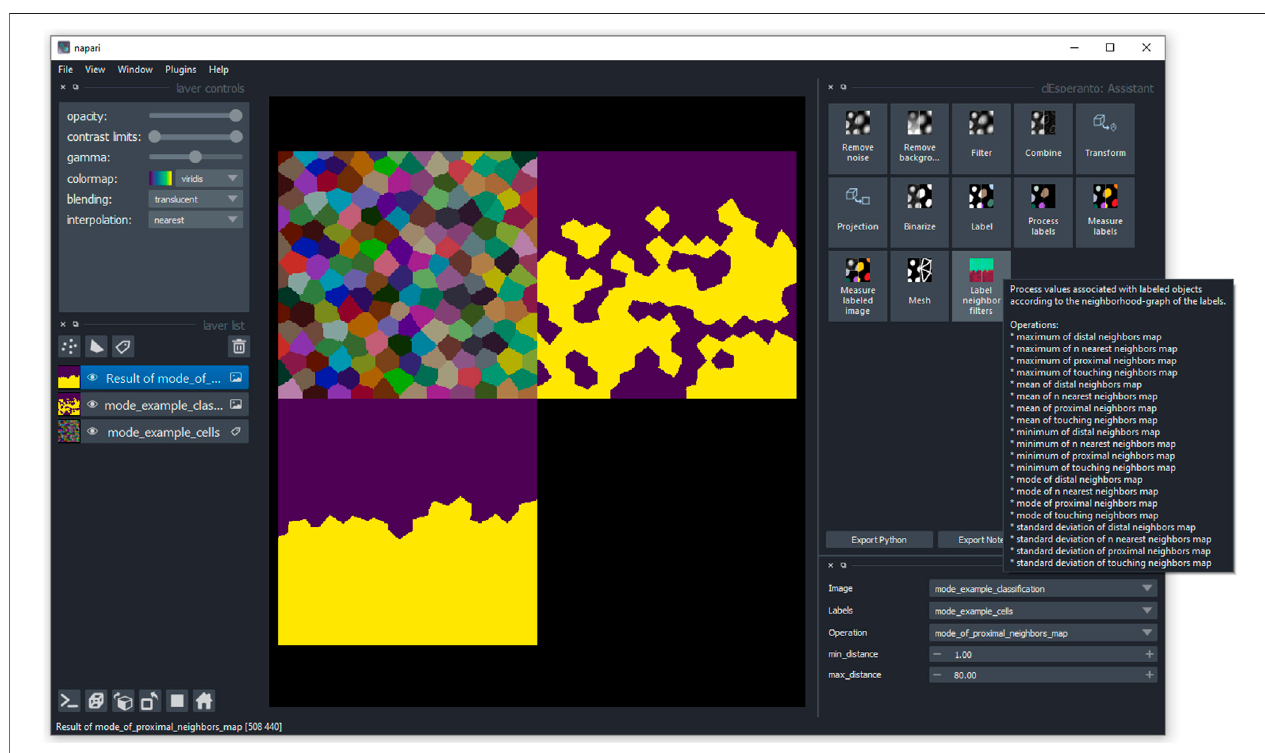
FIGURE 6 | User interface in napari: Users can access the label neighborhood fi lters via the napari-pyclesperanto-assistant user interface. After clicking on a category,theusercanselecta fi ltersuchasmodeofproximalneighborsand fi netuneparametersuchasthemaximumdistanceofcellstobeconsideredfordetermining the